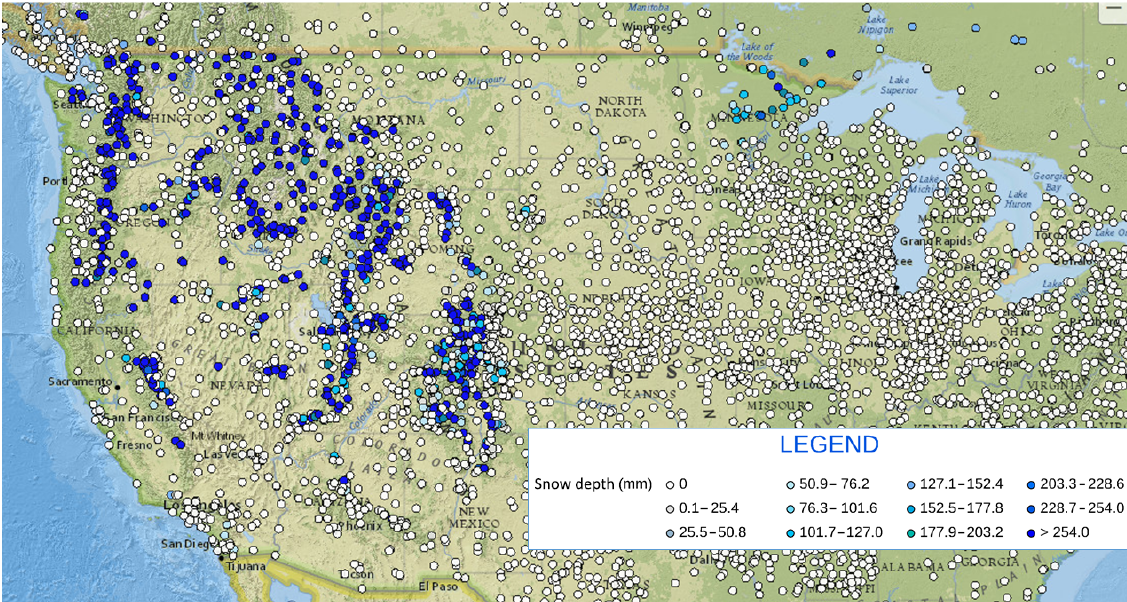
Figure 5. Snow depth (mm) from 16 April 2012 for part of the continental US. Source: NOAA National Climate Data Center (https: //gis.ncdc.noaa.gov/maps/ncei/summaries/daily, last access: 16 December 2019). The map was developed by the US Government and is in the public domain.